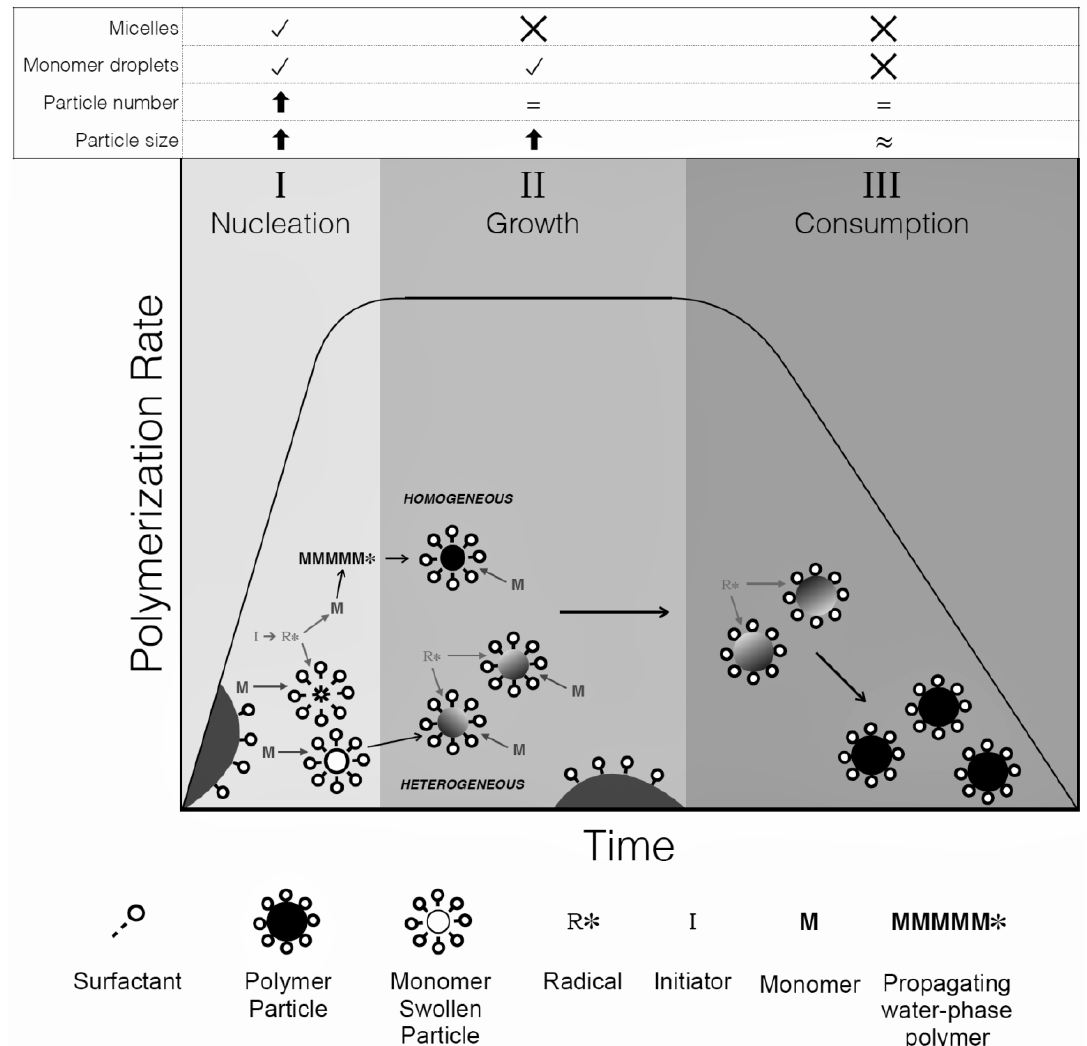
Figure 1. Mechanisms of the three intervals of an emulsion polymerization.